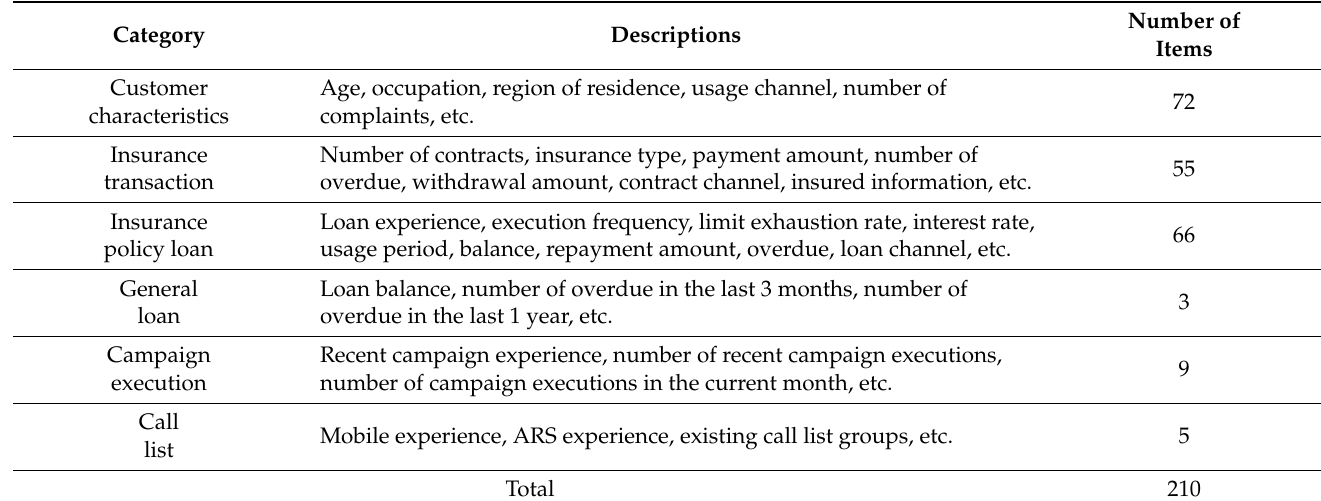
Table 3. Descriptions of data category.